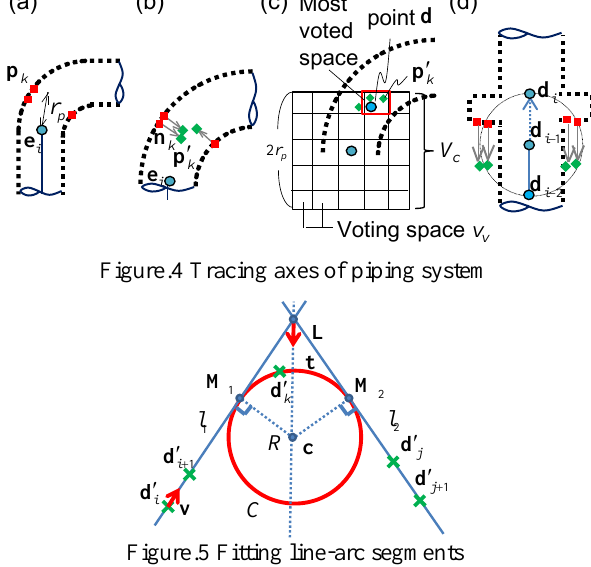
Figure.5 Fitting line-arc